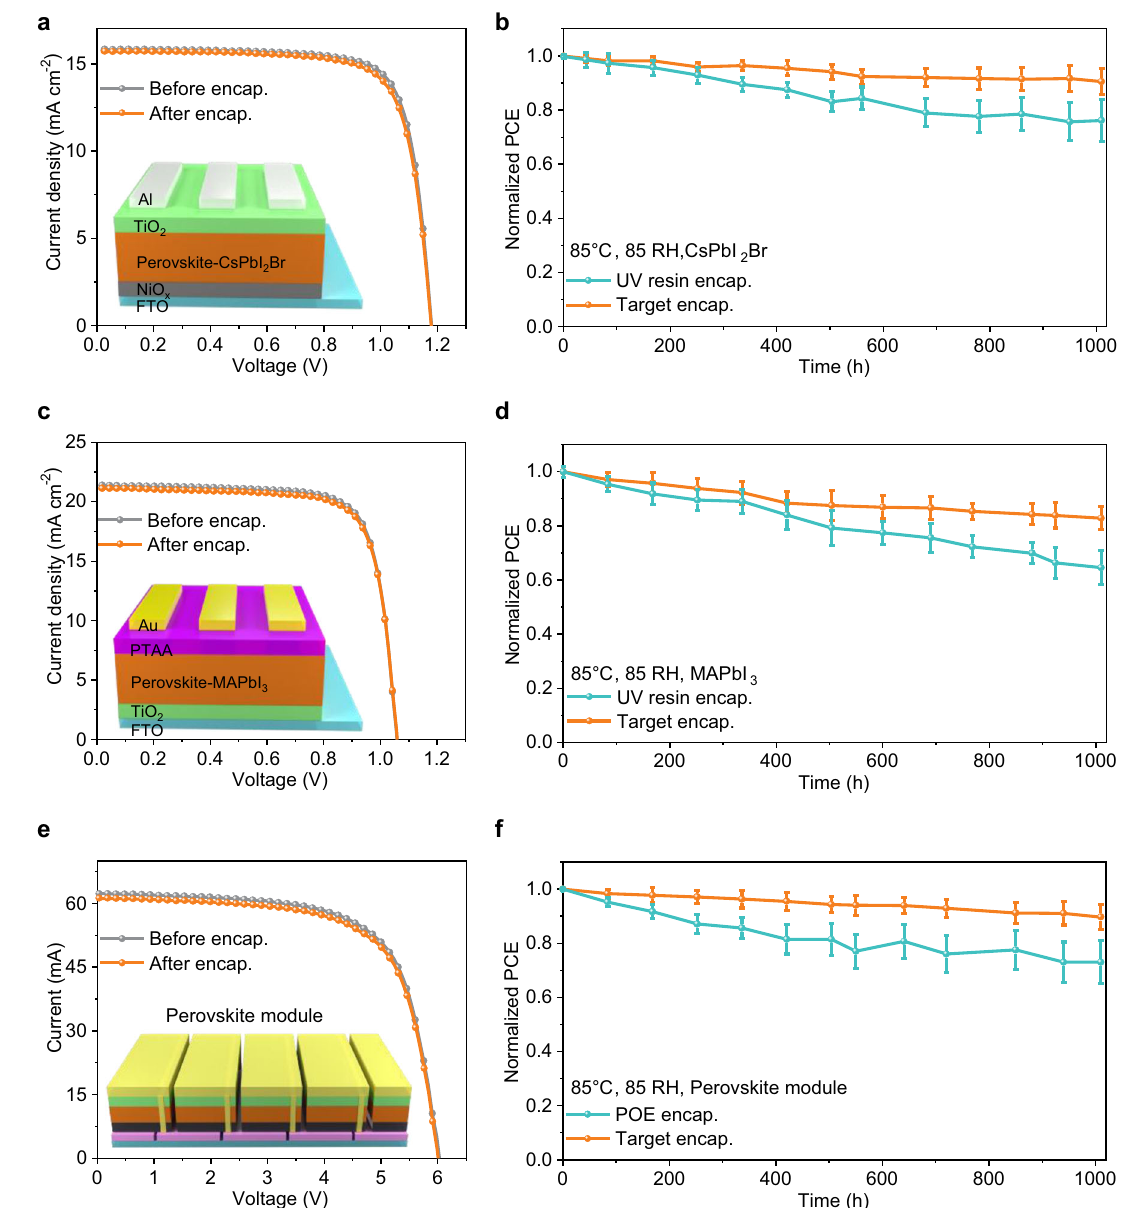
Fig. 5 | Photovoltaic performance based on the different components and structures. a The J-V curves of CsPbI 2 Br perovskite-based inverted devices before and after target encapsulation. b The PCE attenuation curve with UV resin and targetencapsulationbasedonthedevicesofCsPbI 2 Brperovskiteunderdampheat test. c The J-V curves of MAPbI 3 perovskite-based normal devices before and after target encapsulation. d The PCE attenuation curve with UV resin and target encapsulation based on the devices of MAPbI 3 perovskite under damp heat test.